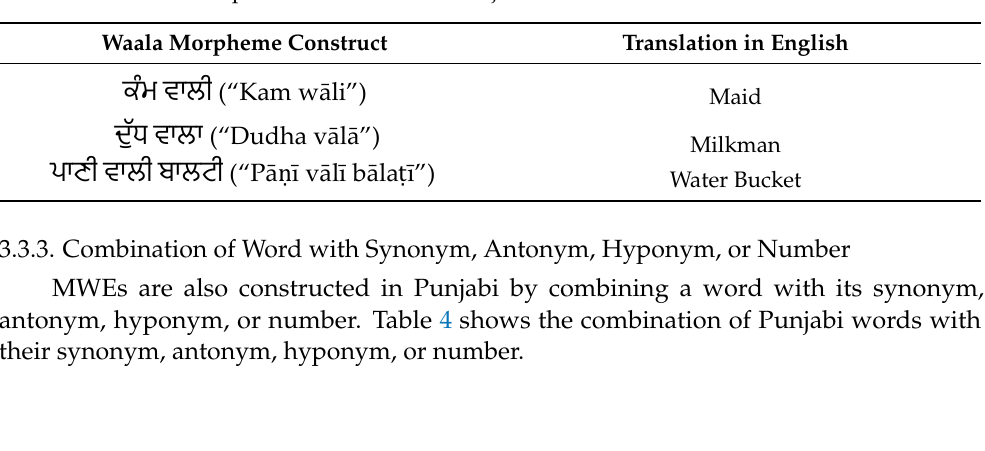
Table 4. Combination of Punjabi words with their synonym, antonym, hyponym, or number. Punjabi Word